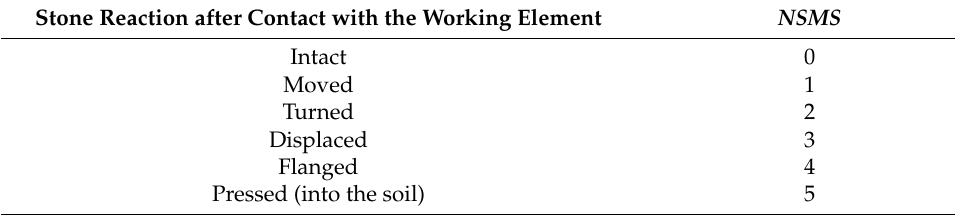
Table 4. Numerical Stone Movement Scale— NSMS. Stone Reaction after Contact with the Working Element